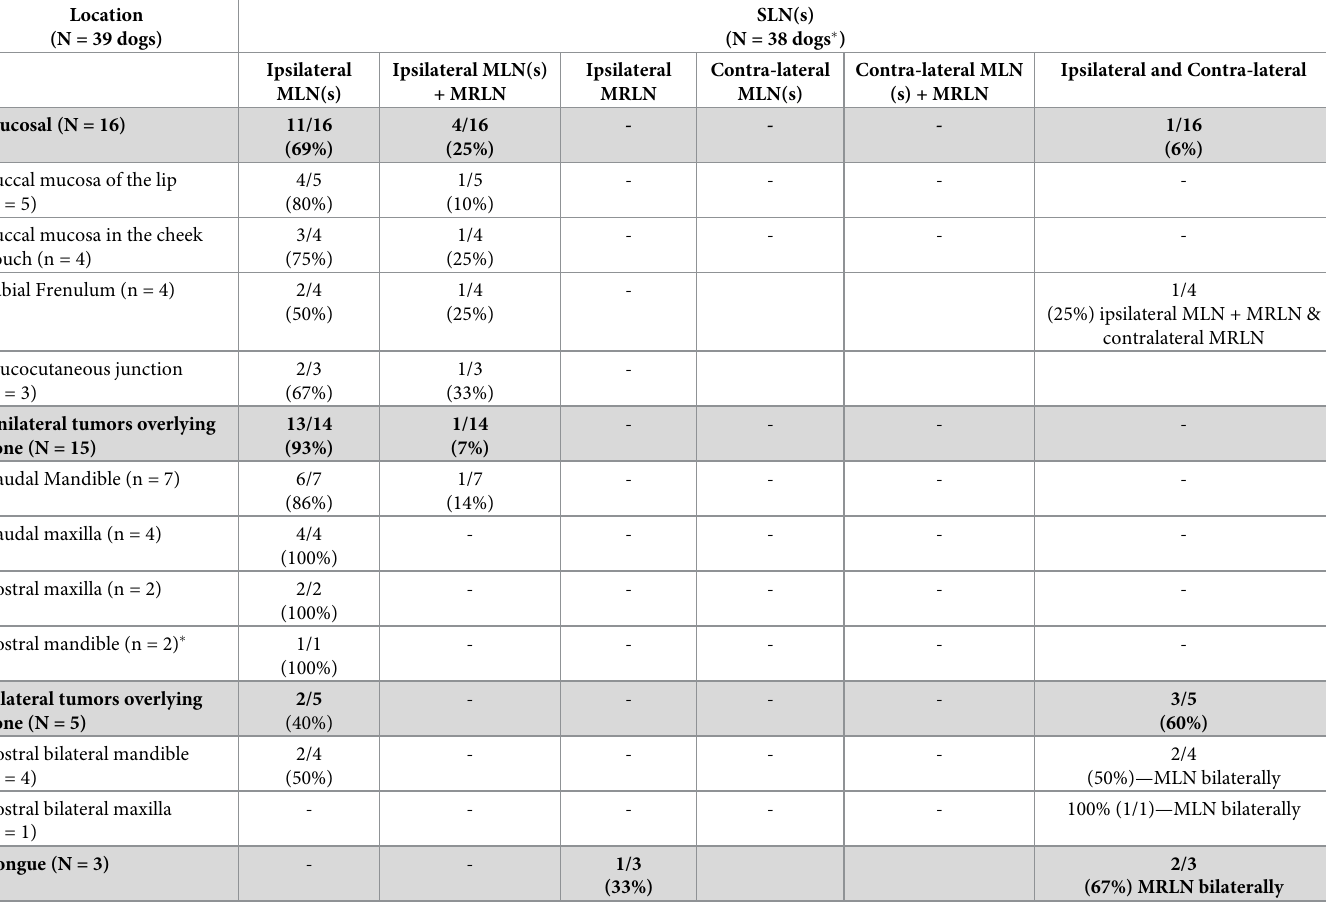
Table 5. Primary tumor location in 39 dogs with oral tumors and identified sentinel lymph nodes (SLNs) with ICTL for prediction of metastasis to the right and/or left mandibular lymph nodes (MLNs), and/or medial retropharyngeal lymph node